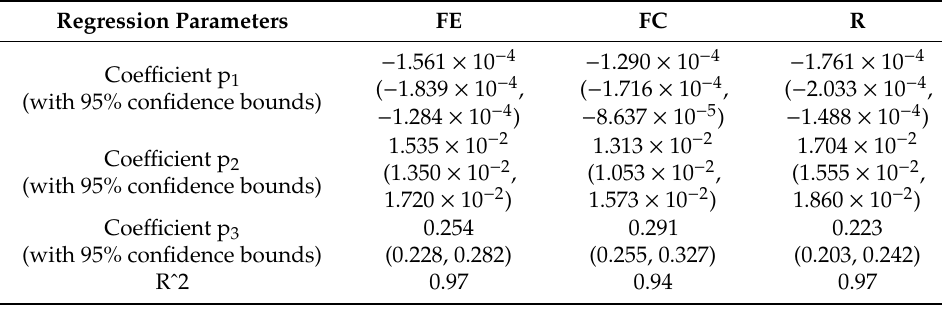
Table 8. Coe ffi cient values for the NTR-s regression model (R2).